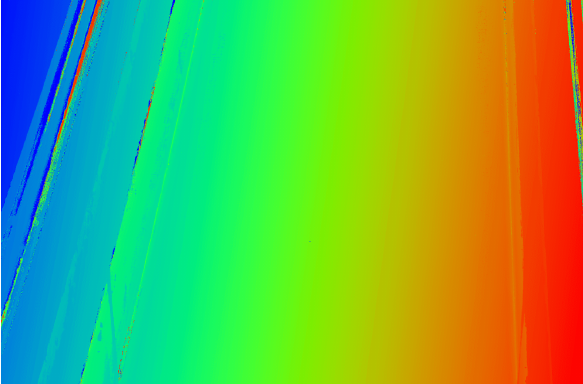
Figure 7: Projector column numbers after decoding the camera image